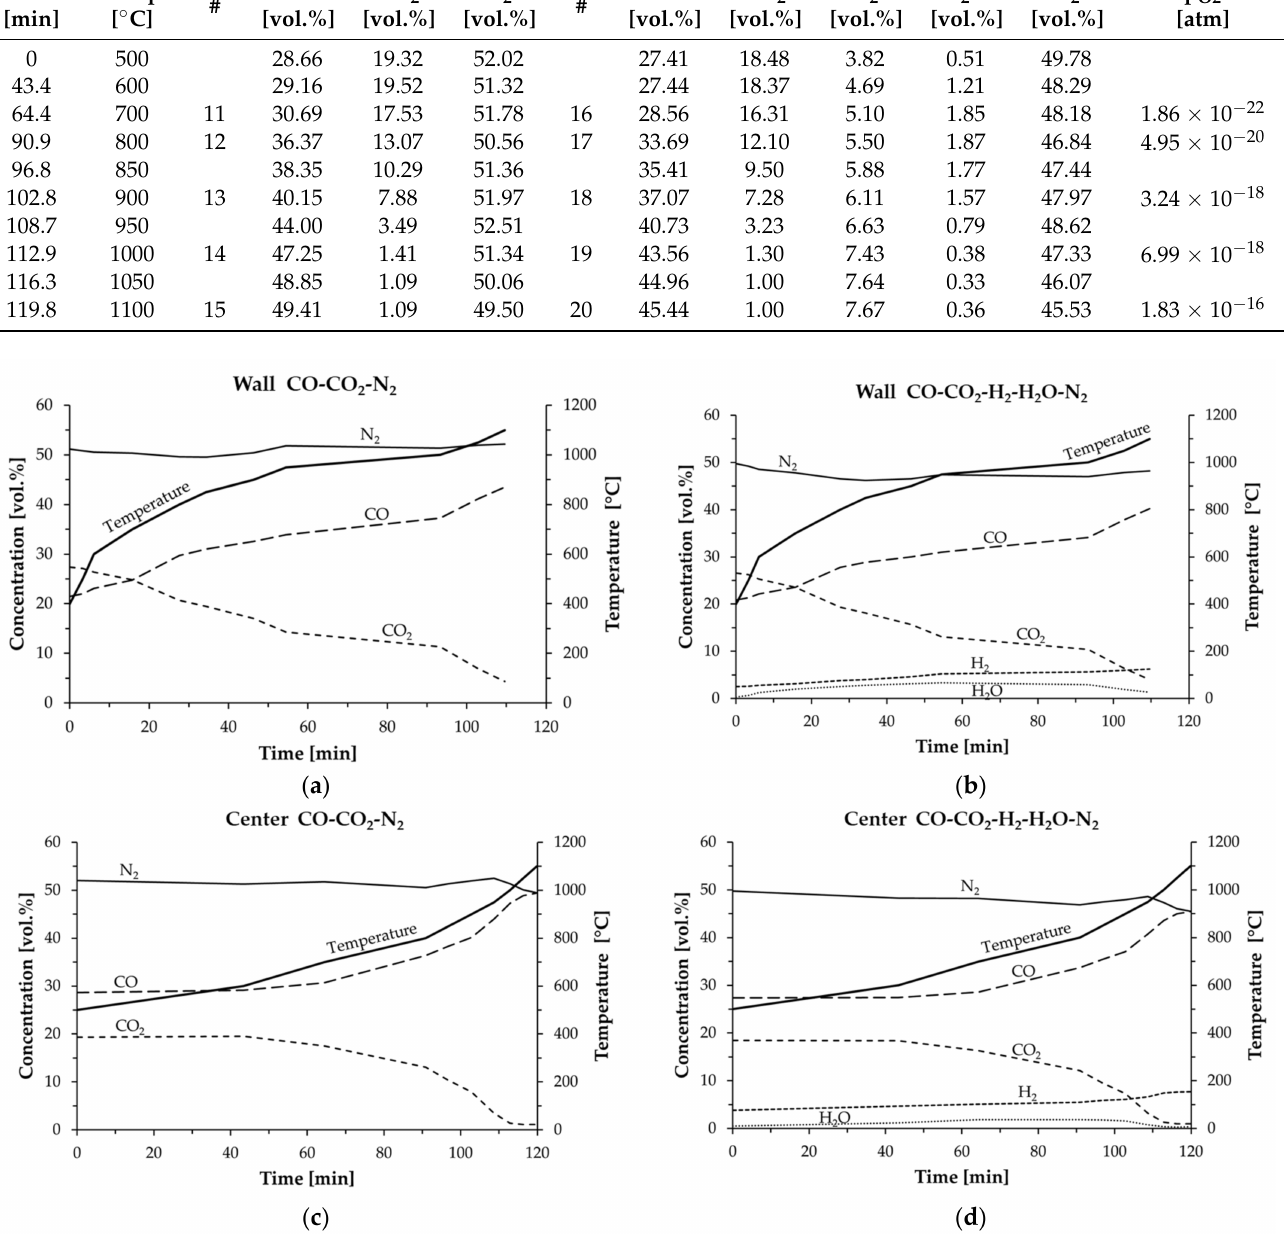
Figure 2. Gas composition and temperature as a function of time in non-isothermal reduction, using ( a ) the wall profile in CO-CO 2 -N 2 gas, ( b ) the wall profile in CO-CO 2 -H 2 -H 2 O-N 2 gas, ( c ) the center profile in CO-CO 2 -N 2 gas, and ( d ) the center profile in CO-CO 2 -H 2 -H 2 O-N 2